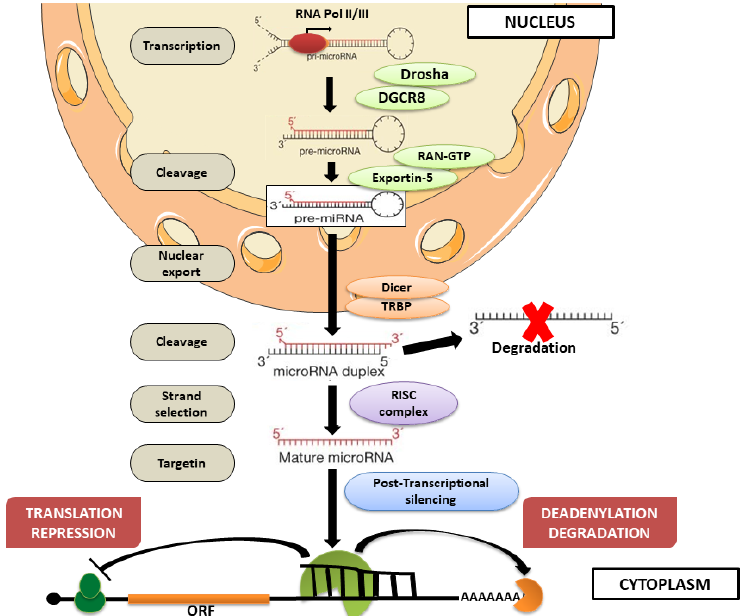
Figure 1. The miRNA biogenesis process. RNA Pol II/III transcribed miRNA genes to form pri- miRNA transcript. Pri-miRNAs are processed by microprocessor complex Drosha – DGCR8 in the nucleus to generate pre-miRNAs. After translocation into the cytoplasm by exportin-5 – Ran-GTP, pre-miRNAs are processed by RNase Dicer to form the mature miRNA duplex. Subsequently, one strand is degraded, while only one strand of the duplex is stably associated with RISC. The mature miRNA can interact with target mRNAs, containing partially complementary miRNA binding sites within the 3 ’ UTR region, inducing translation repression, mRNA target cleavage, or mRNA deadenylation. The image was created using the image bank of Servier Medical Art (Available online: http://smart.servier.com/, accessed on 30 December 2022), licensed under a Creative Commons Attribution 3.0 Unported License (Available online: https://creativecommons.org/licenses/by/3.0/, accessed on 30 December 2022). RNA polymerase II or III: RNA Pol II/III; microRNA: miRNA; primary miRNA: pri-miRNA; ras-related nuclear protein: Ran; Guanosine-5 (cid:48) -triphosphate: GTP; precursor miRNA: pre-miRNA; RNA-induced silencing complex: RISC; messenger RNA: